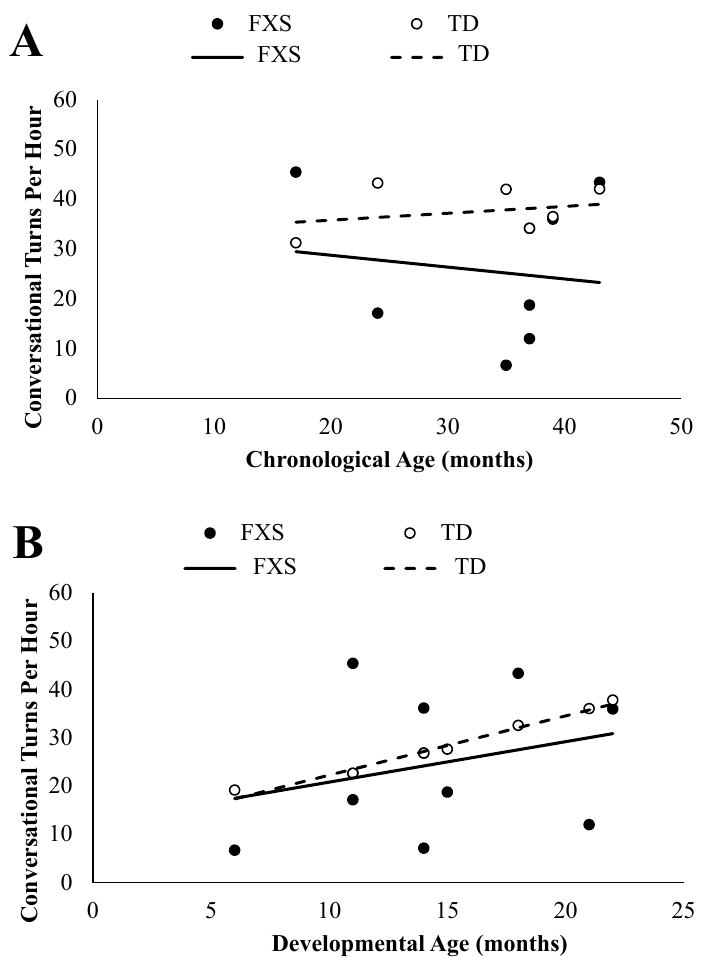
Figure 2. Infants and toddlers with fragile X syndrome (FXS) conversational turns per hour plotted in comparison to their chronologically age-matched ( A ) and developmentally age-matched ( B ) typically developing (TD) peers with trend lines.